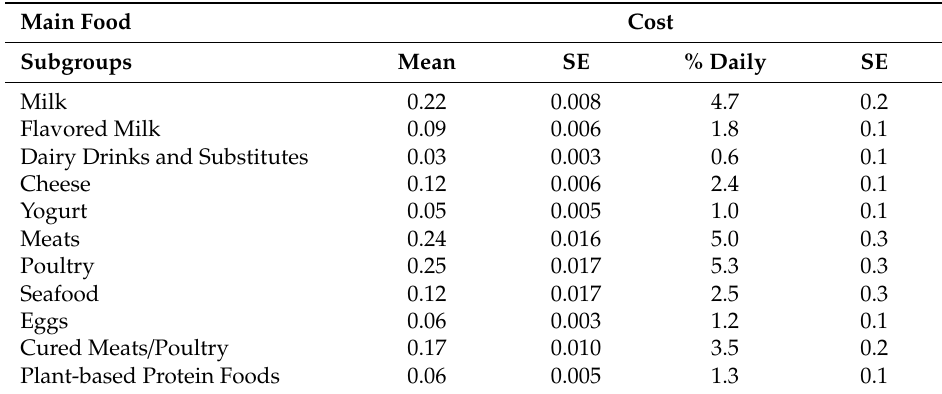
Table 4. Estimated percentage of children, age 2–18 years, who consume dairy and other protein food subgroups on a given day, and the estimated mean daily cost ($) of each food subgroup expressed in dollars and as a percentage of the total cost of food.